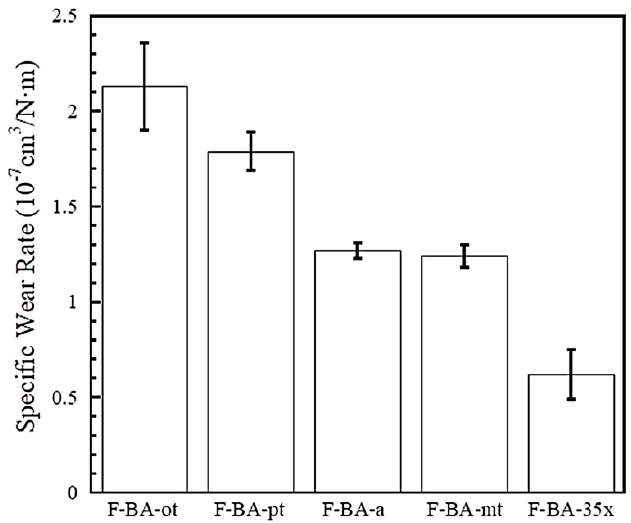
Figure 6. Specific wear rate at 25 °C of polybenzoxazine composites prepared from different benzoxazine resins.